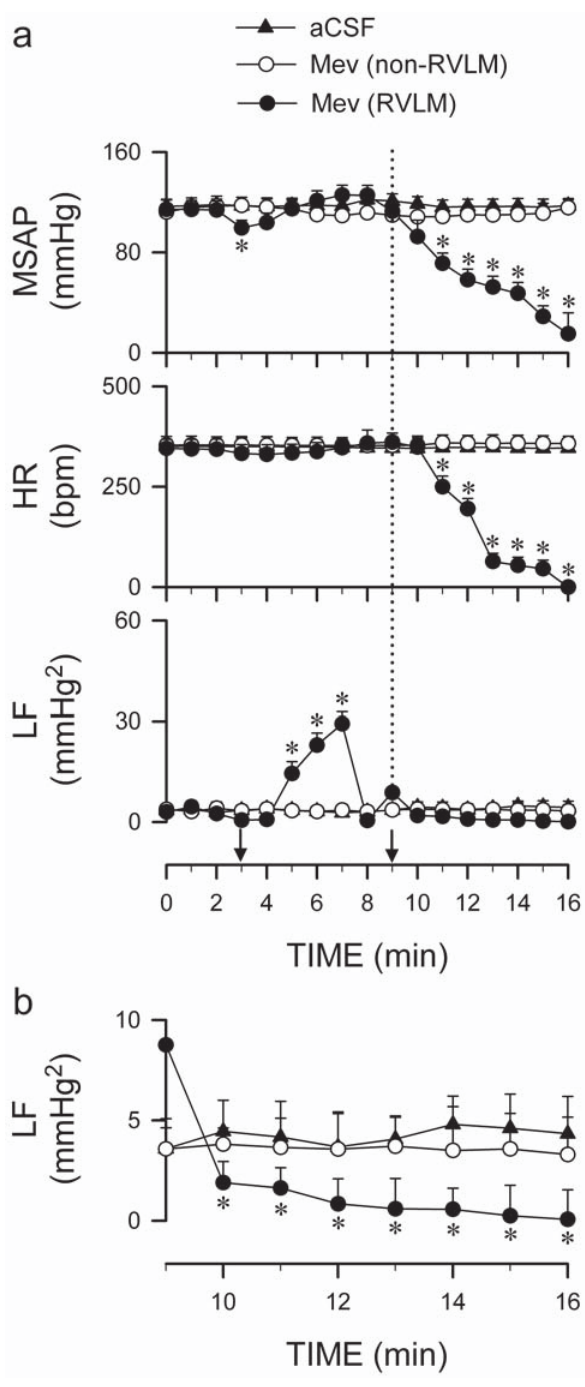
Figure 3. Loss of functional integrity of RVLM precedes cardiovascular depression. (a) Temporal changes in MSAP, HR or power density of LF component of SAP spectrum in rats that received consecutive microinjections (at arrows) of a lethal dose of Mev (280 nmol) bilaterally into the RVLM or sites immediately adjacent to the RVLM (non-RVLM). (b) Re-drawn of (a) between the 9 th [dotted line in (a)] and 16 th min on an expanded scale showing temporal changes in LF power. Values are mean 6 SEM of 5–7 animals per experimental group. * p , 0.05 versus artificial cerebrospinal fluid (aCSF) group or non- RVLM group at corresponding time-points in the post hoc Scheffe´ multiple-range analysis following two-way ANOVA.